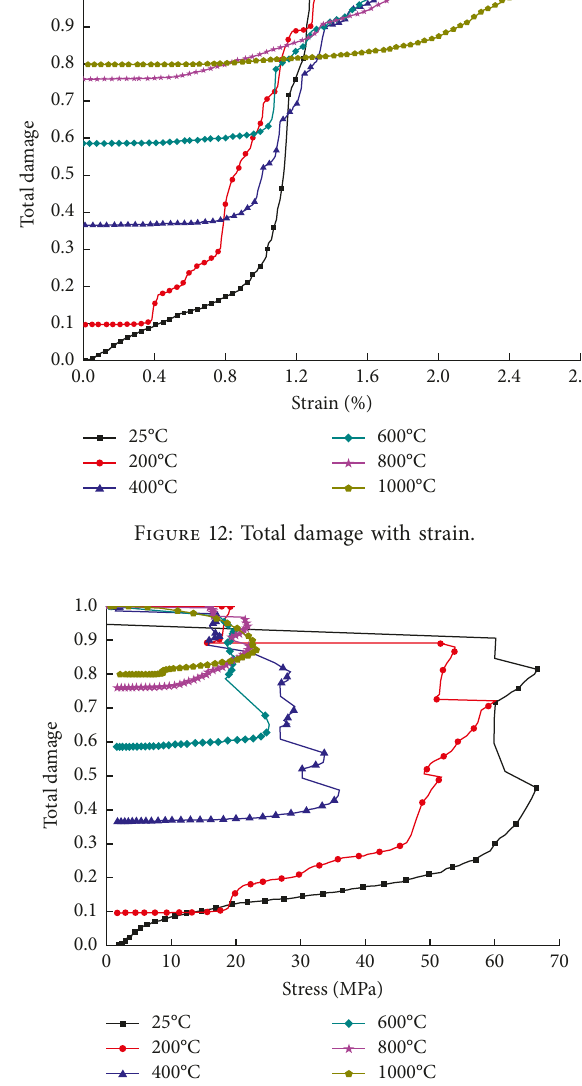
Figure 11: Average thermal damage with temperature.